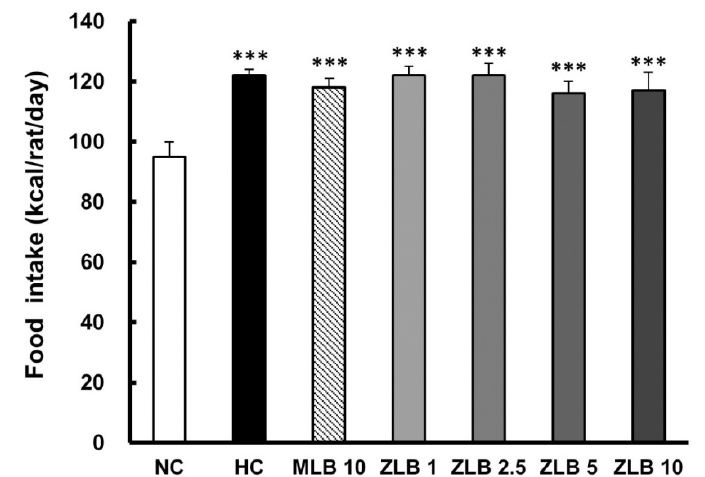
Figure 2. Effects of MLB and ZLB on appetite and weight gain. Food intake was recorded for a month. NC, normal diet control; HC, high-fat-diet (HFD) control; MLB10, HFD with 10 mg/kg/day of MLB; ZLB1, ZLB2.5, ZLB5, and ZLB10, HFD with 1, 2.5, 5, and 10 mg/kg/day of ZLB. Values are expressed as mean ± SD (n = 6 per group). *** P < 0.001 vs. NC group.